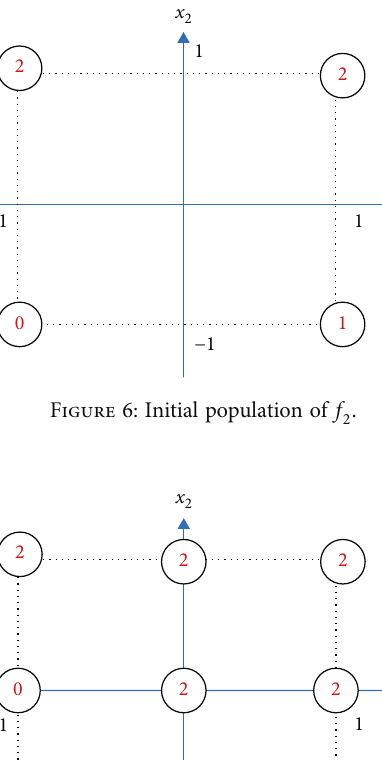
Figure 7: First generation of f